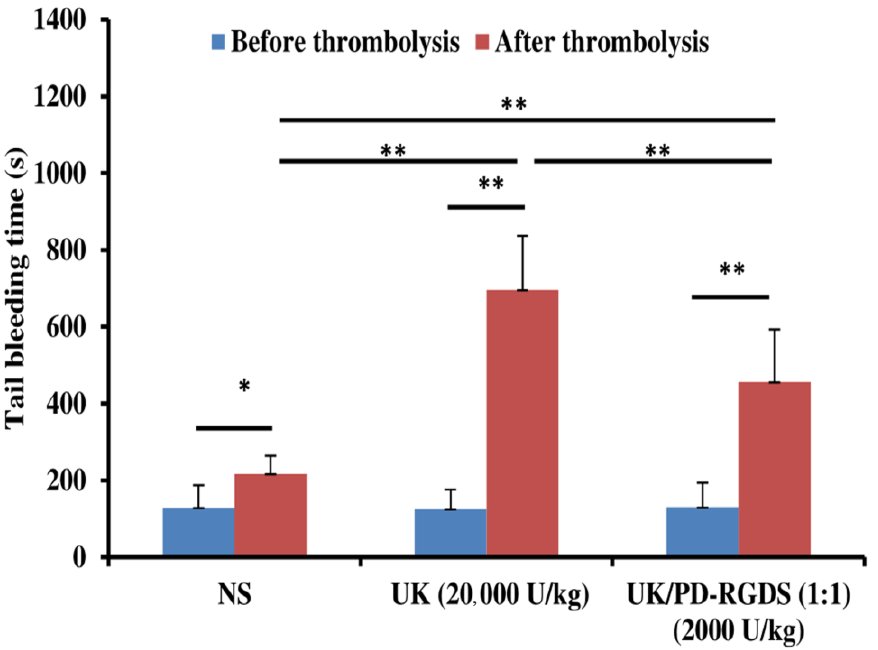
Figure 4. Tail bleeding times of with UK/PD-RGDS complexes (n = 5) * p < 0.05; ** p < 0.01.